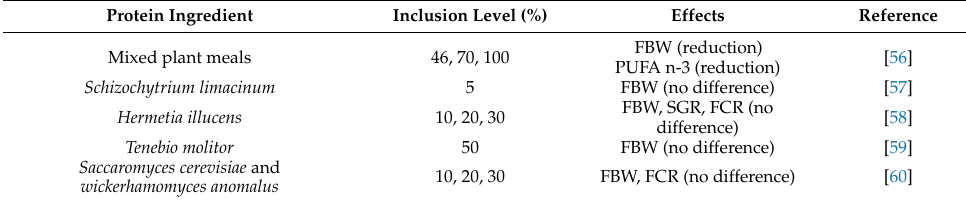
Table 9. Effects of alternative diets on growth and quality parameters in rainbow trout. Protein Ingredient Inclusion Level (%) Effects Reference Mixed plant meals 46, 70,